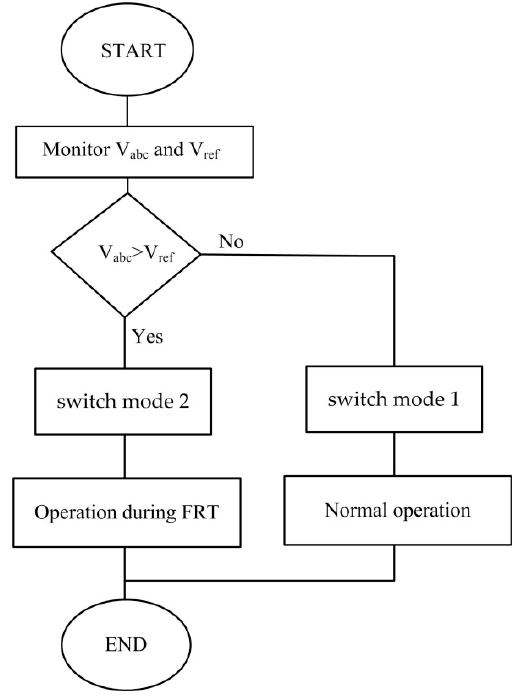
Figure 2. Flowchart of the proposed control algorithm.